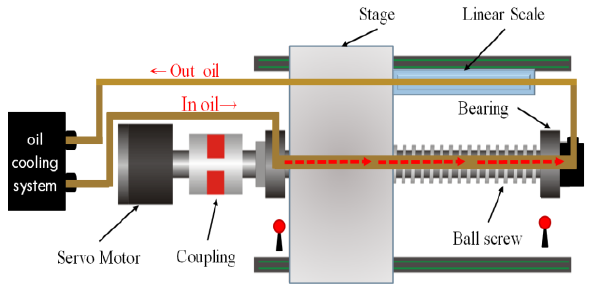
Figure 2. Oil-cooling circulating system around the hollow ball screw in Figure 1.